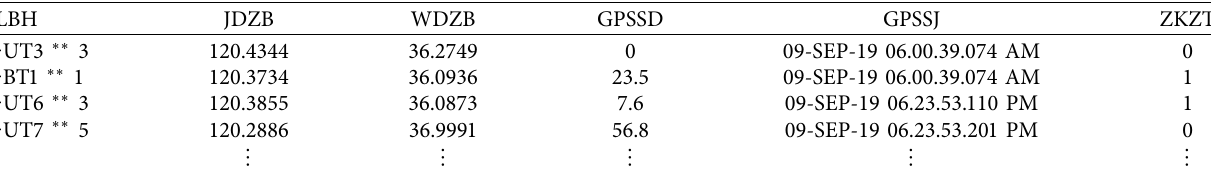
Table 2: Taxi GPS data